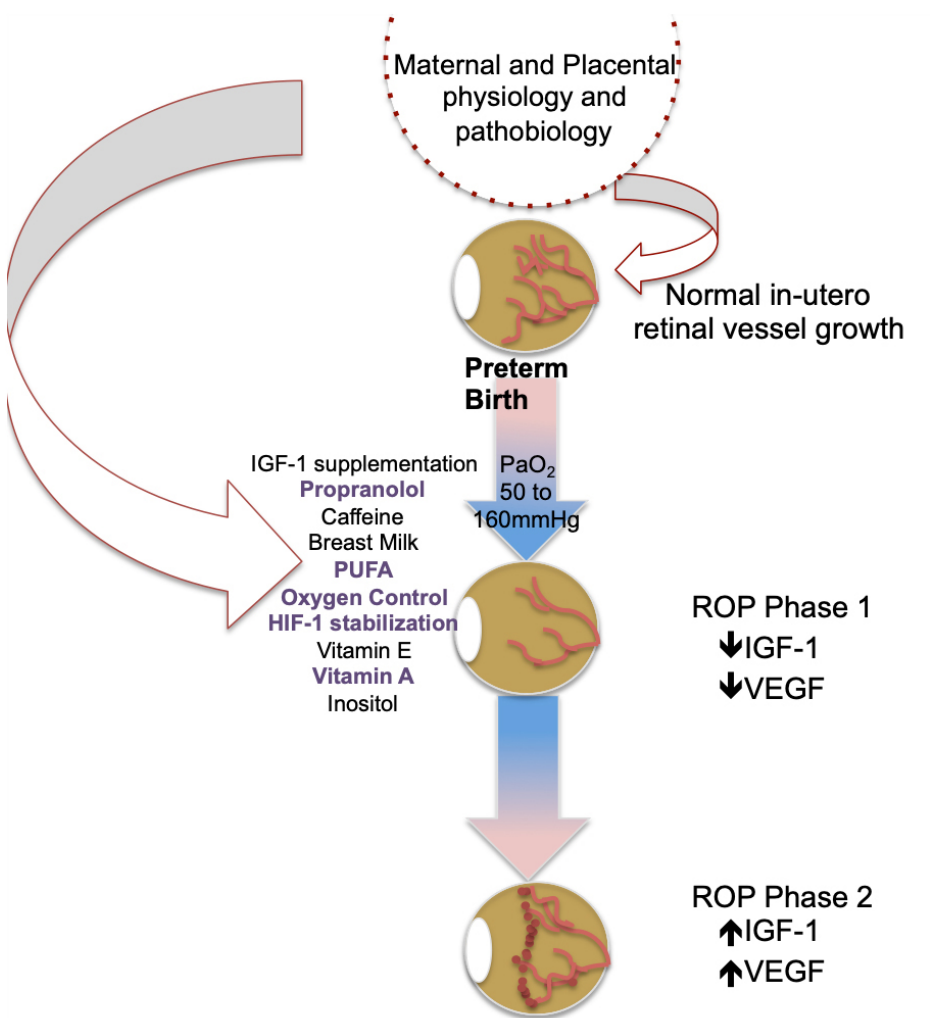
Figure 3. Maternal and placental-informed ROP